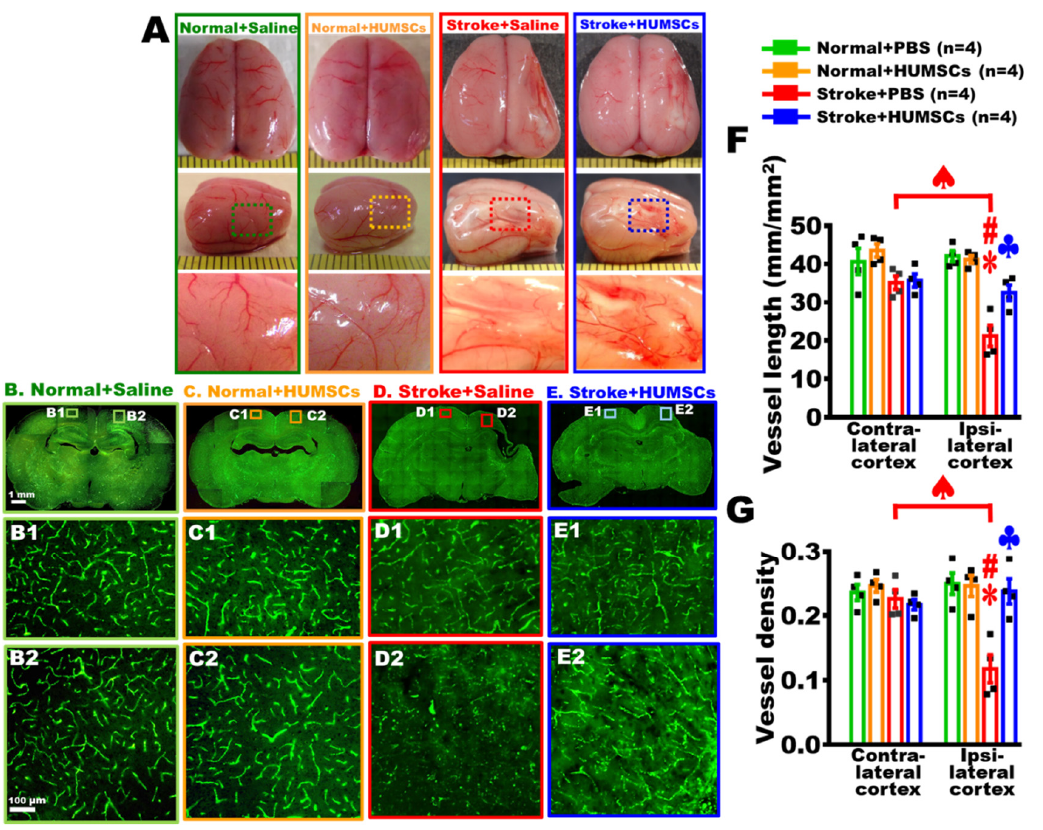
Figure 5. HUMSCs transplantation promoted angiogenesis in the infarcted brain of the rats with chronic stroke. On day 56 post stroke, the brains were photographed from a superior view (top panel) and a lateral view (intermediate panel and high magnification in the bottom panel) to observe the distribution of superficial blood vessels of the cerebral cortex. More blood vessels are observed on the surface of the Stroke + HUMSCs group ( A ). From coronal brain sections at bregma − 2.4 mm, vessels in the contralateral cortex ( B1 , C1 , D1 , E1 ) and ipsilateral cortex ( B2 , C2 , D2 , E2 ) are visualized by fluorescein isothiocyanate-conjugated dextran amine. Boxed areas in the photographs are magnified in the bottom row ( B1 , B2 , C1 , C2 , D1 , D2 , E1 , E2 ). The total vessel length per mm 2 ( F ) and vessel density ( G ) in the infarcted region are significantly greater in the cortex of the Stroke + HUMSCs group than those in the Stroke + Saline group. Normal + Saline n = 4, Normal + HUMSCs n = 4, Stroke + Saline n = 4, Stroke + HUMSCs n = 4. ∗ , vs. ipsilateral cortex of the Normal + Saline group, p < 0.05. #, vs. ipsilateral cortex of the Normal + HUMSCs group, p < 0.05. ♣ , vs. ipsilateral cortex of the Stroke + Saline group, p < 0.05. ♠ , contra-lateral vs. ipsi-lateral cortex in the Stroke + Saline group, p < 0.05. ■ is the value of individual experiment. 2.7. Engrafted HUMSCs Survive and Migrate in the Infarcted Cortex of Rats with Chronic Stroke The nucleus of HUMSCs was labeled with bisBenzimide to track their survival and distribution. On day 56, the fluorescence imaging showed that plenty of blue clusters of cells were found at bregma +0.3 mm, i.e., the first site for HUMSCs transplantation, in the Stroke + HUMSCs group. From bregma +0.6 mm to +0.1 mm, there were still many cells in blue fluorescence identified (Figure 6A). At the second transplantation site (bregma − 5.2 mm) of the Stroke + HUMSCs group, large clusters of cells could also be found. Similarly, HUMSCs existed in clusters from bregma − 4.9 mm to bregma − 5.5 mm (Figure 6B). Anti-human-specific nuclei antigen immunohistochemical staining was further employed to investigate HUMSCs distribution in rats with chronic stroke. The results showed that large clusters of HUMSCs were seen at the first and secondary stem cell transplantation sites of the cerebral cortex in the Stroke + HUMSCs group (at bregma +0.3 mm and − 5.2 mm). The number of HUMSCs gradually decreased as the distance away